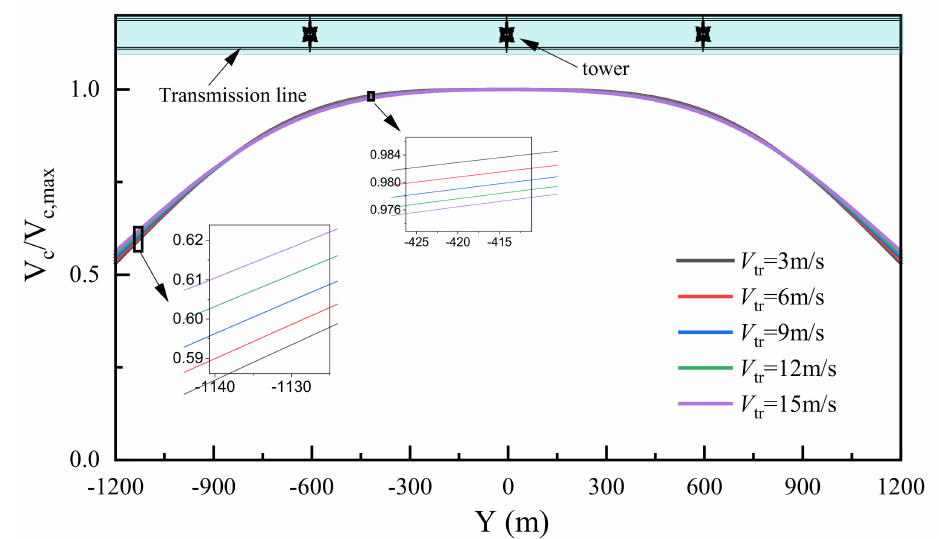
Figure 15. Variation of transverse wind profiles of downburst with V t